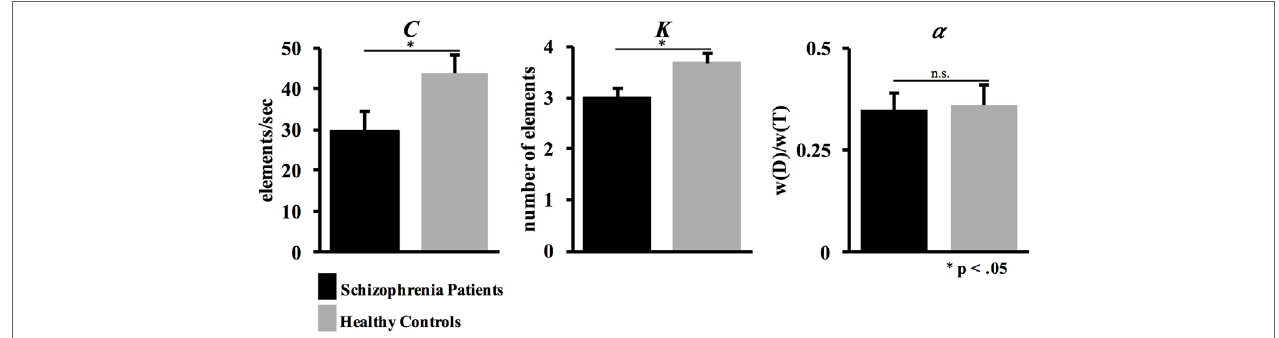
FiGUrE 4 | Whole- and partial-report results. Mean estimates and SEs for the Theory of Visual Attention parameters processing speed C , short-term memory capacity K , and efficiency of top-down control α